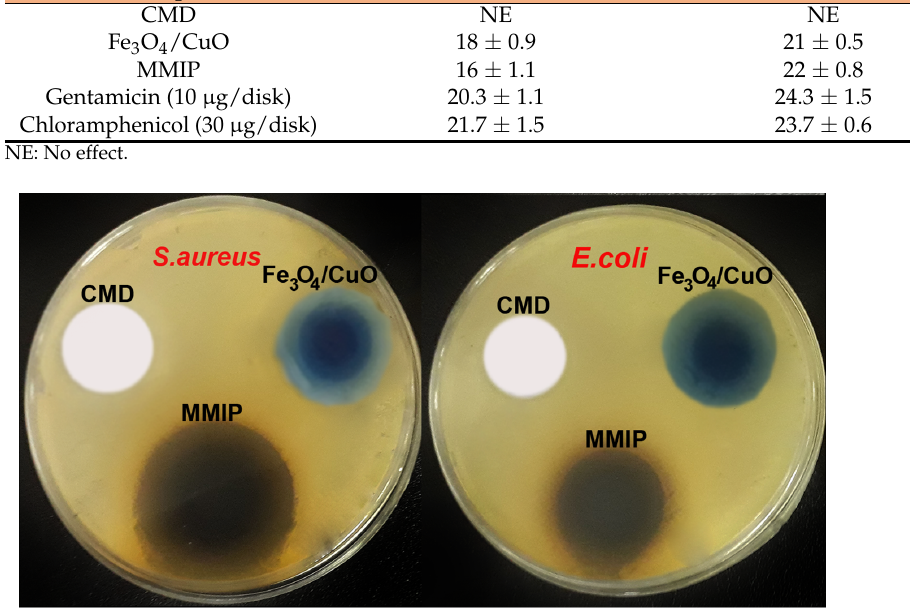
Figure 6. Cell culture of antibacterial activity of Fe 3 O 4 /CuO, carboxymethyl dextrin (CMD), and magnetic molecularly imprinted polymer (MMIP) against Escherichia coli ( E. coli ) and Staphylococcus aureus ( S. aureus ). Table 2. Antibacterial activity data of Fe 3 O 4 /CuO, CMD, and MMIP against Escherichia coli ( E.coli ) and Staphylococcus aureus ( S. aureus ). The diameter of the inhibitory zone of bacteria was measured in millimeters (mm).